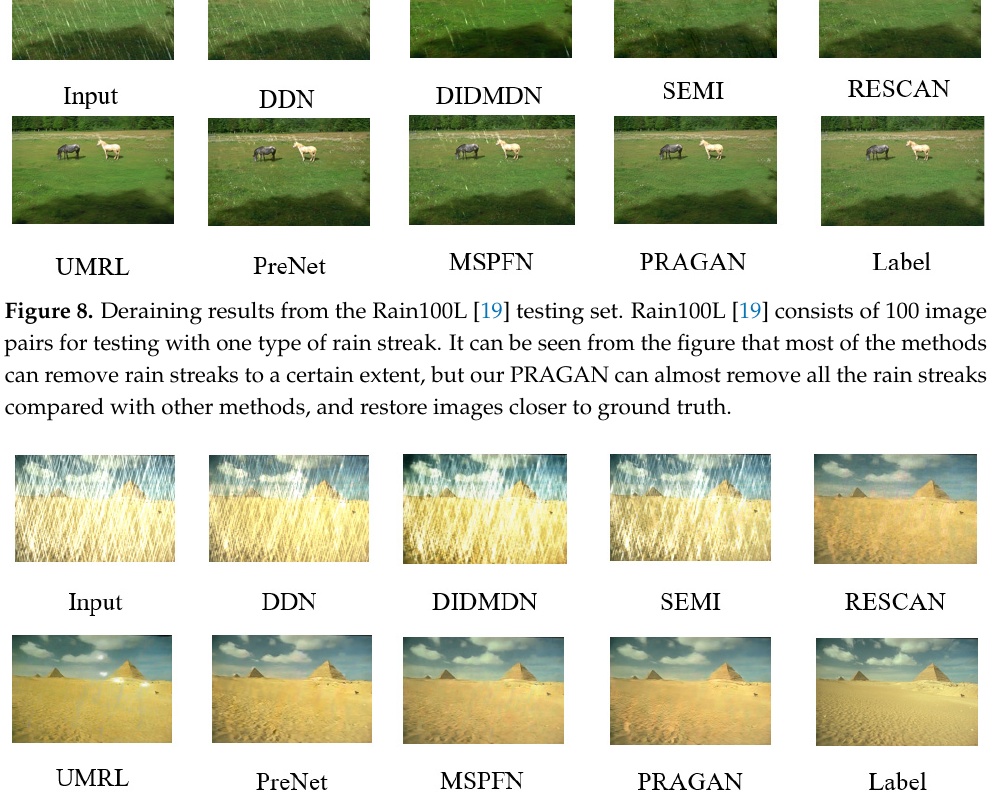
Figure 9. Deraining results from the Rain100H [19] testing set. In contrast to the relatively simple Rain100L [19], Rain100H [19] contains five types of streak directions, so part of the rain removal method was not effective. Our method needed only a quarter of the 13,712 image pairs for training.